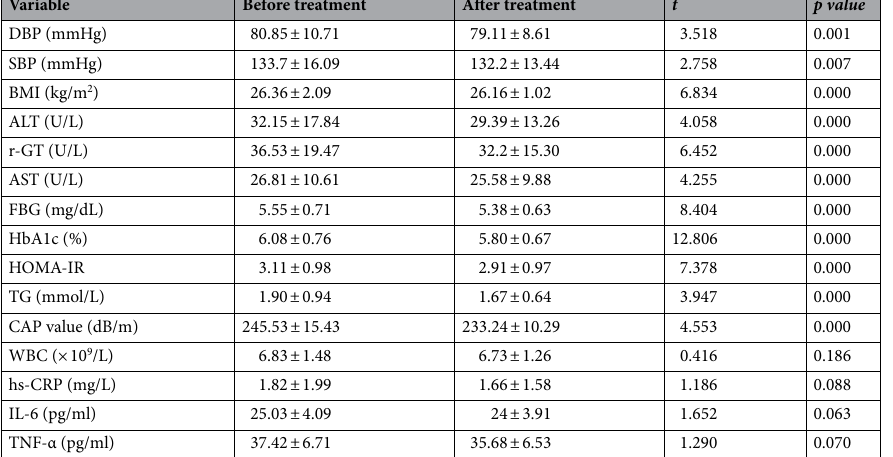
Table 1. Comparison of therapeutic effects before and after treatment in the control group. SBP systolic blood pressure, DBP diastolic blood pressure, BMI body mass index, WBC white blood cell, ALT alanine aminotransferase, γ-GT γ-glutamyltranspeptidase, AST aspartate aminotransferase, hs-CRP high-sensitivity C-reactive protein, FBG fasting blood glucose, HbA1c glycosylated haemoglobin, HOMA-IR homeostasis model assessment of insulin resistance, TG triglyceride, CAP controlled attenuation parameter, IL-6 interleukin 6, TNF-α tumour necrosis factor-α. * p value obtained from paired t test.